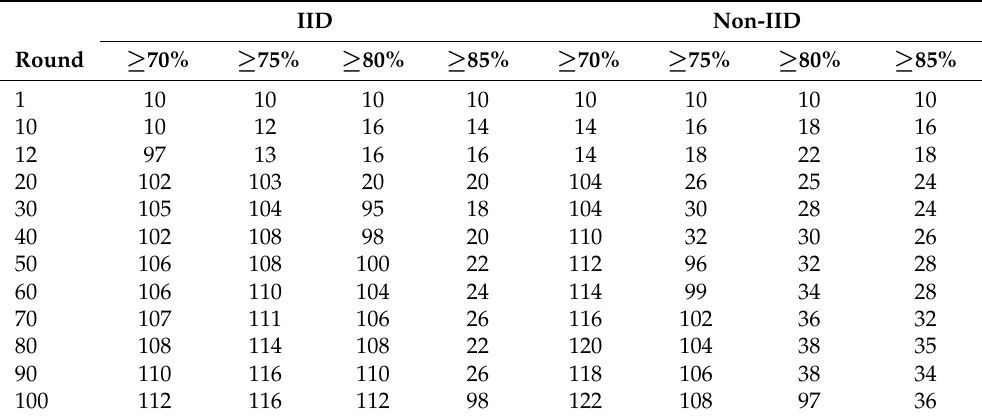
Table 7. Total number of selected representatives when the given accuracy threshold is reached in CelebA dataset at different rounds.